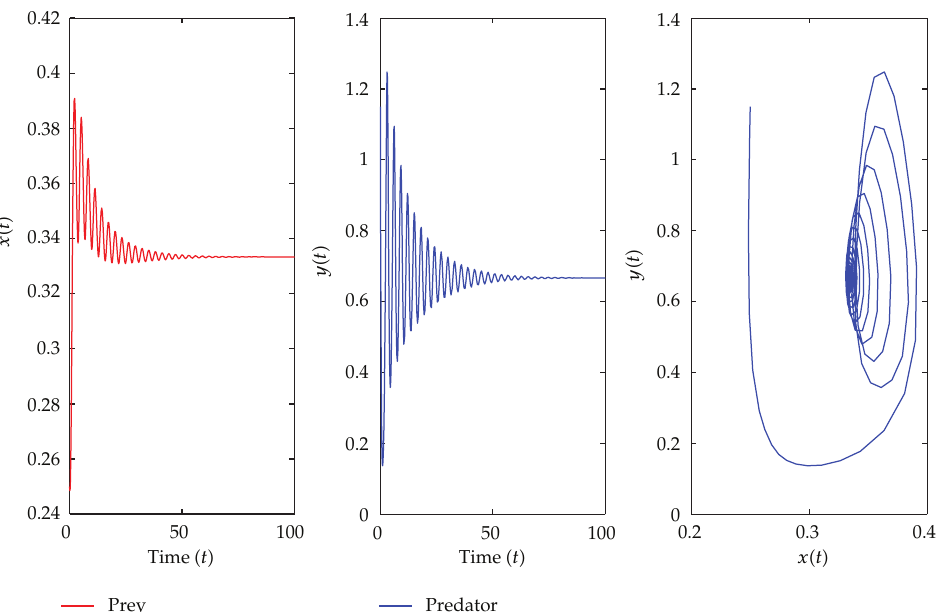
Figure 3: E (cid:7) 0 . 3333 , 0 . 6666 (cid:8) is asymptotically stable when τ 2 (cid:6) 0 . 68 < τ 20 (cid:6) 0 . 7311 with initial value 0.25,